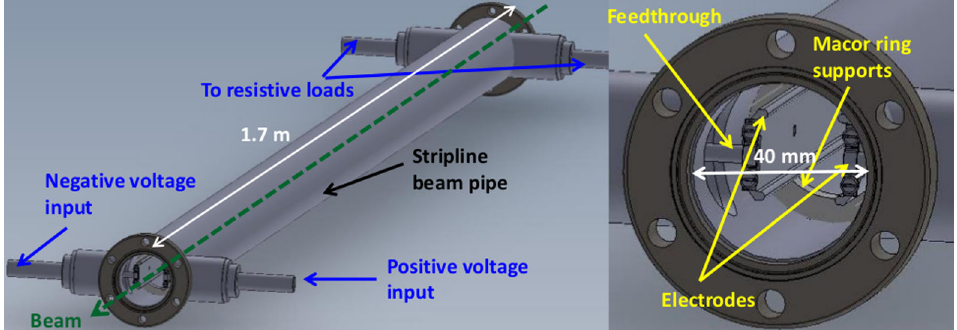
FIG. 1. 3D model of a stripline kicker.